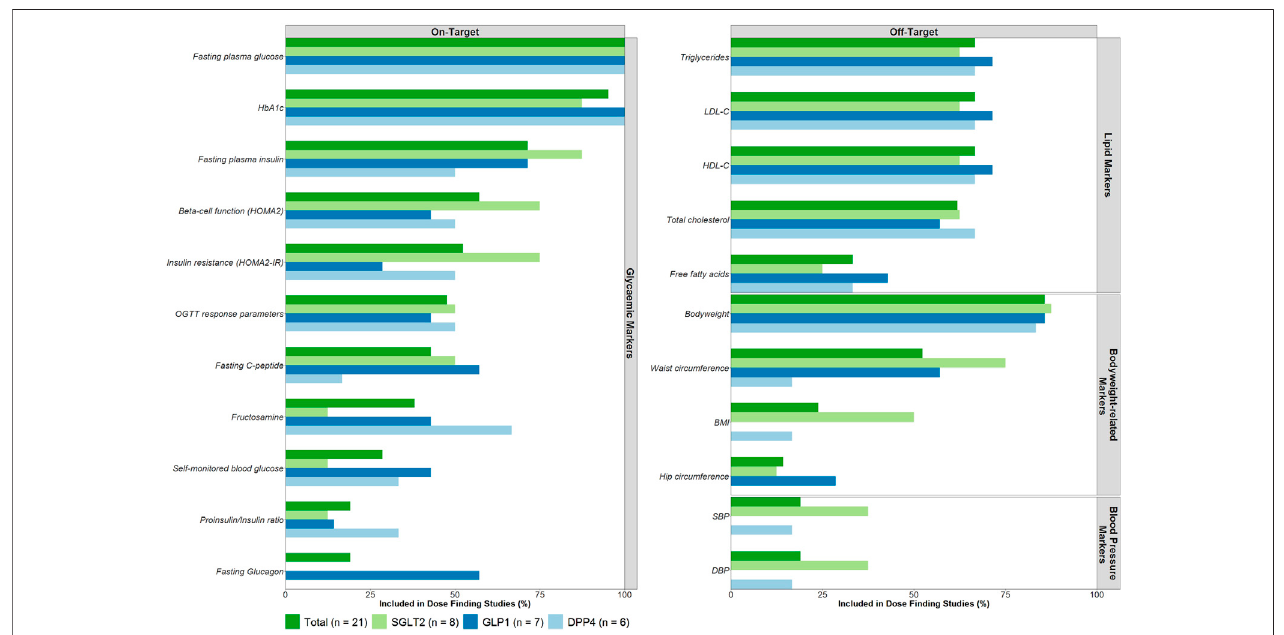
FIGURE 2 | On- and Off-target effects included asef fi cacy endpoints in dose- fi nding trials. Abbreviations: Body Mass Index (BMI), Diastolic blood pressure (DBP), dipeptidyl peptidase-4 (DPP4), glucagon-like peptide-1 (GLP1), glycated hemoglobin (HbA1c), high-density lipoprotein cholesterol (HDL-C), low-density lipoprotein